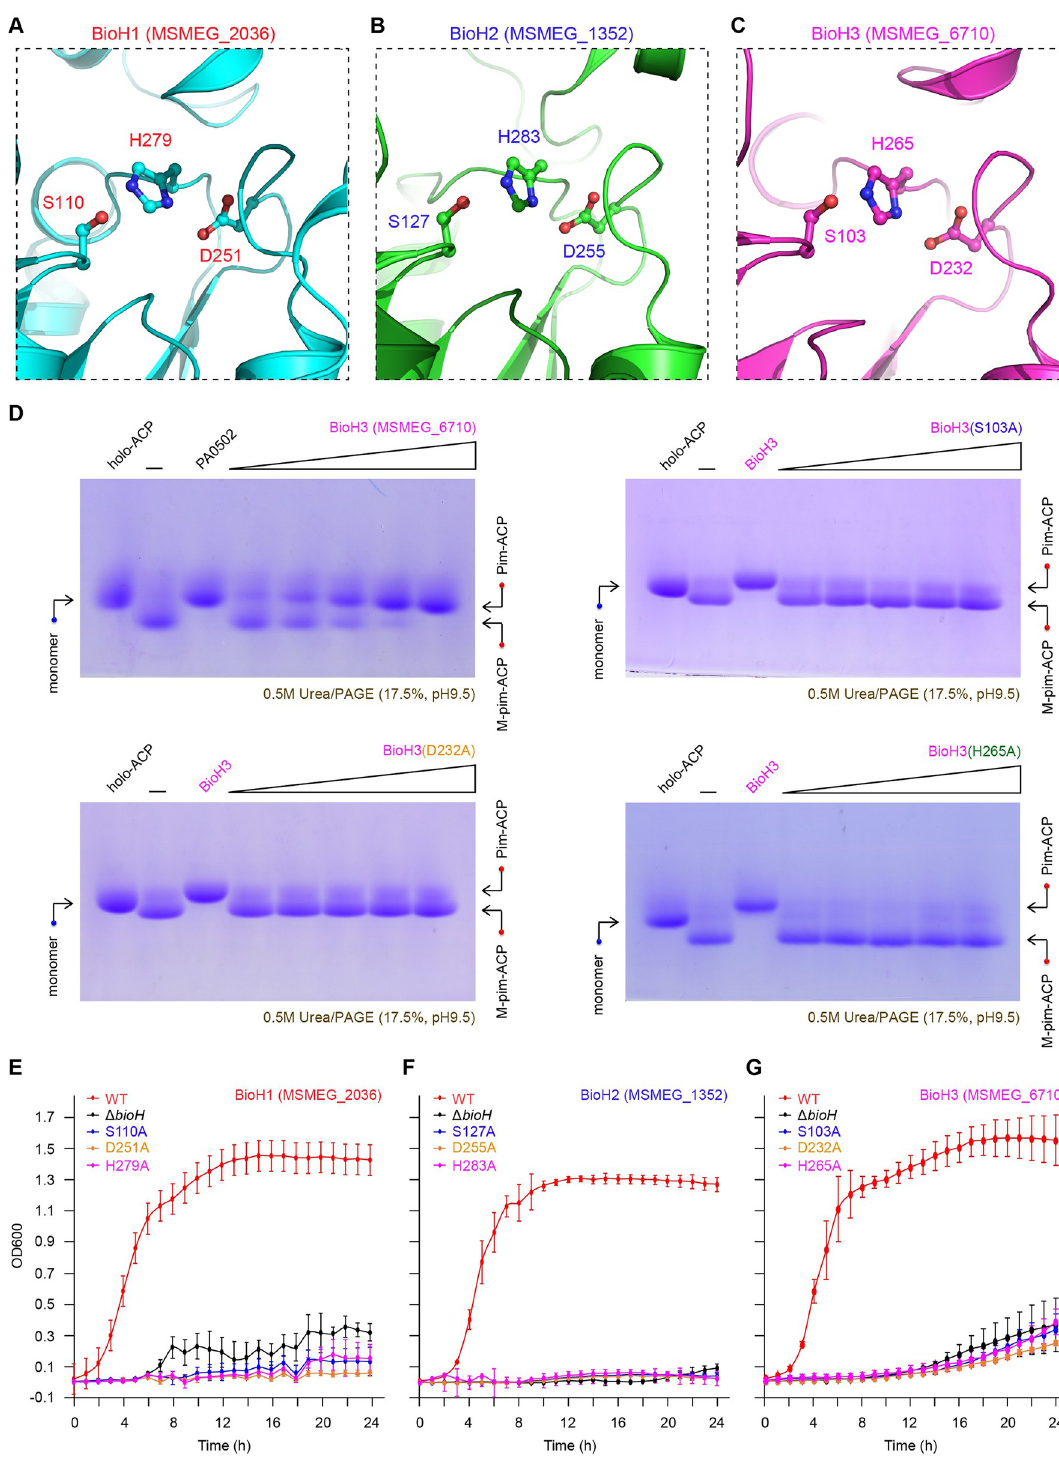
Fig 6. Structure-guided functional analysis for the conserved catalytic triad amongst the three BioH enzymes (BioH1 to BioH3). Structural snapshots of catalytic triads from M . smegmatis BioH1 ( A ) and BioH2 ( B ). Structures of both BioH1 and BioH2 were predicted with Alpha-fold. C. X-ray crystal structure-based visualization for the BioH3 (MSMEG_6710) catalytic triad. The three conserved residues from the catalytic triad correspond to i) S110, D251 & H279 (BioH1); ii) S127, D255 & H283 (BioH2); and iii) S103, D232 & H265 (BioH3). D. Use of enzymatic assays to evaluate the roles of catalytic triad (S103, D232, and H265) in BioH3